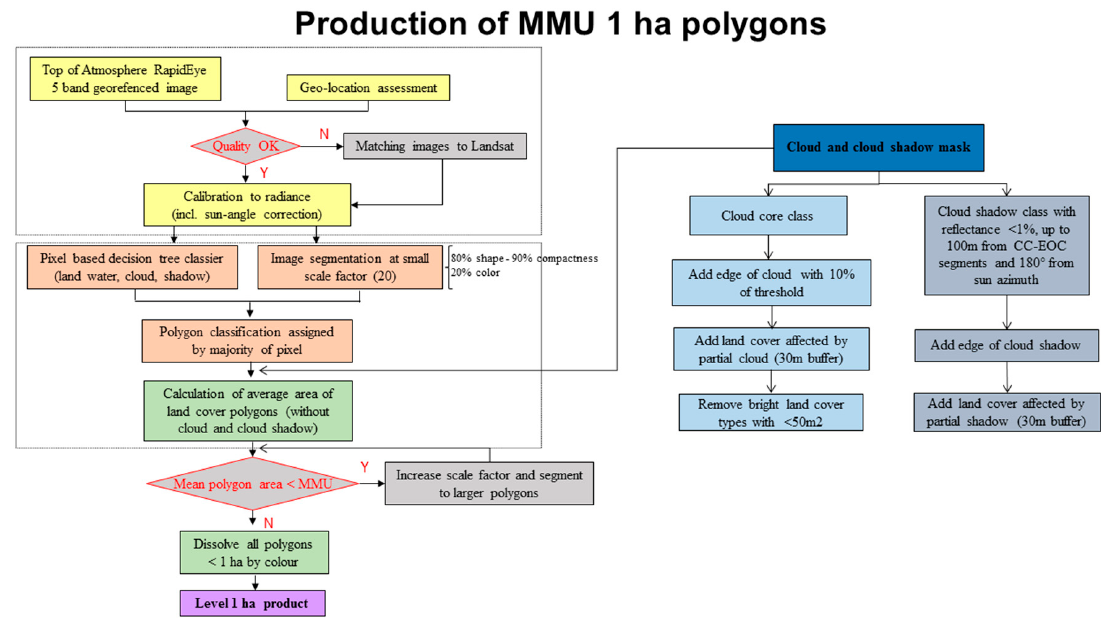
Figure 3. Processing scheme to obtain 1 ha MMUs